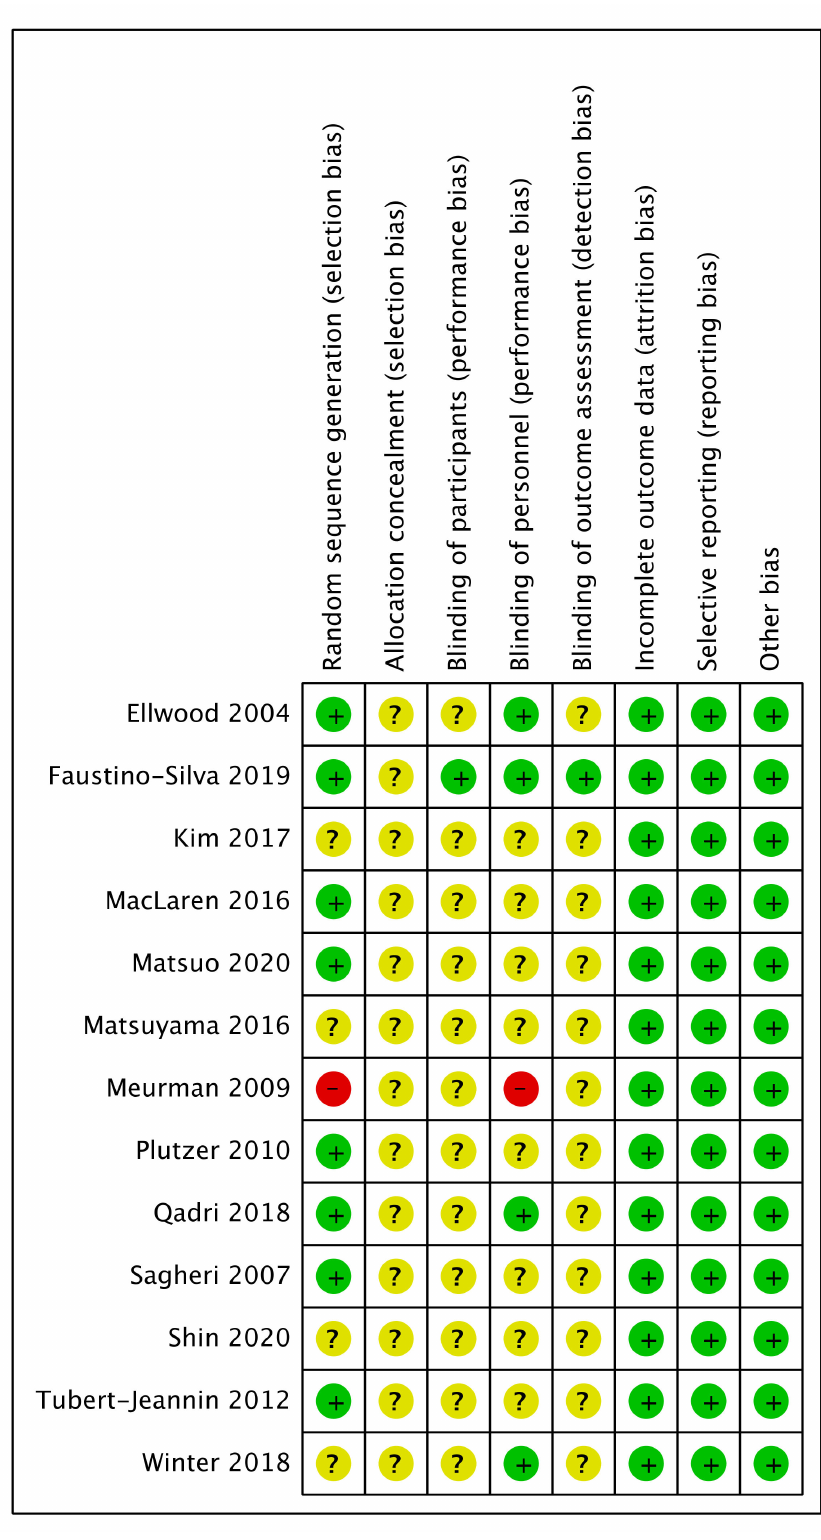
Figure 2. Risk of bias